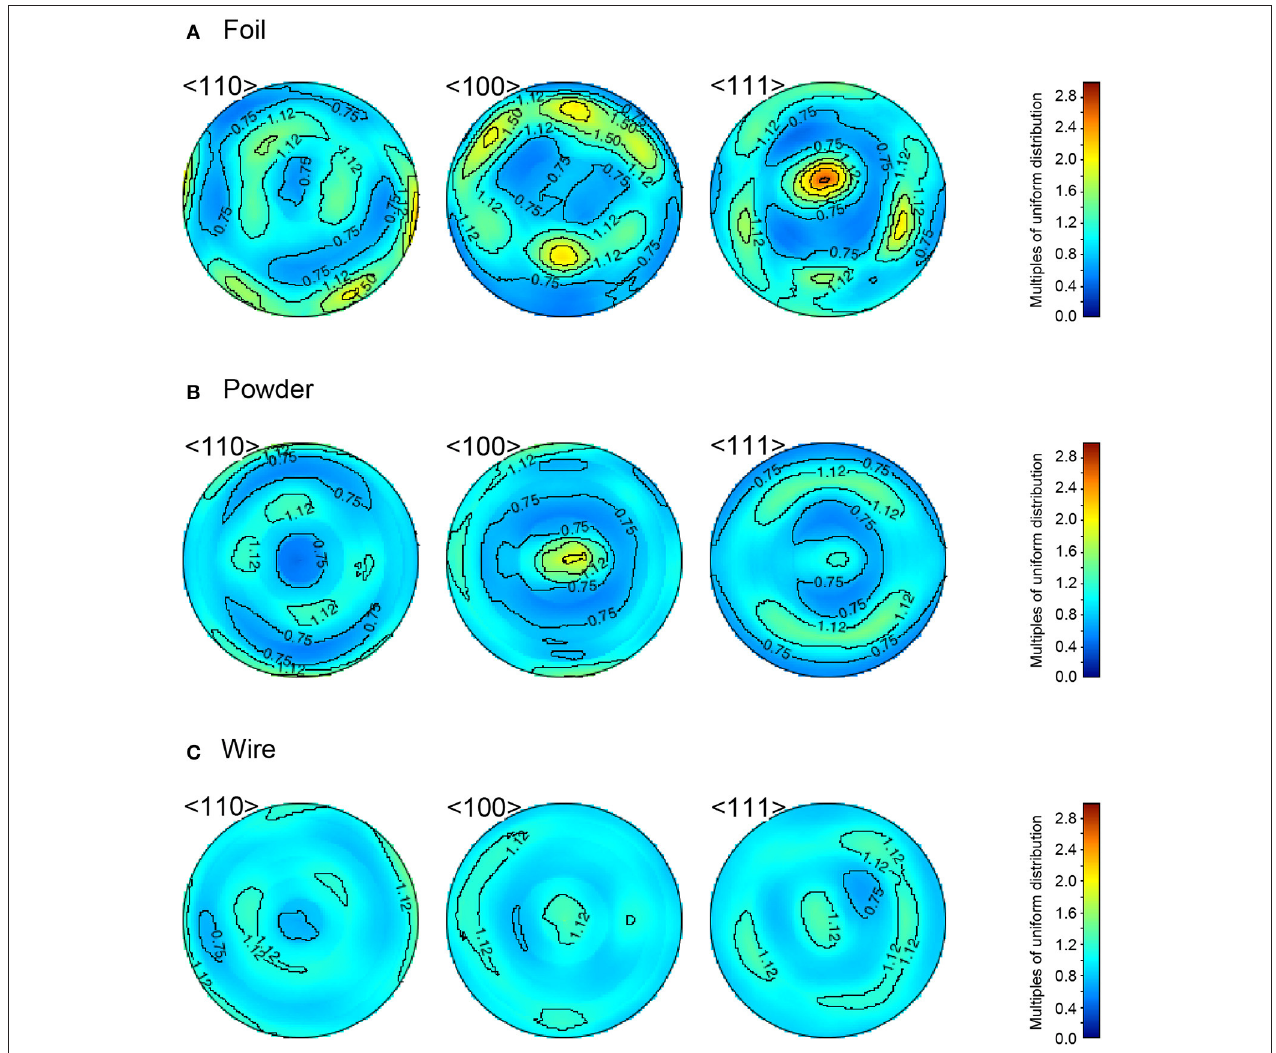
FIGURE 5 | Pole figures of (A) foil, (B) powder, and (C) wire of bcc iron starting materials at ambient conditions showing the variation in the crystallographic orientation of the < 110 > , < 100 > , and < 111 > directions. The direction of a DAC compression is in the center of the pole